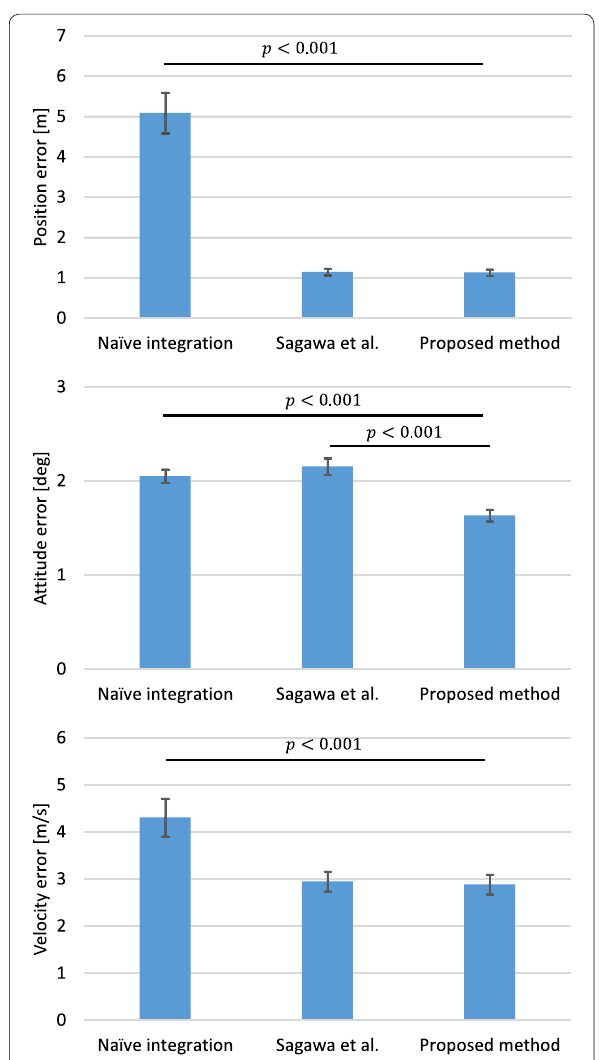
Fig. 3 Motion estimation errors using simulated data with one loop- closing constraint. Error bars indicate standard